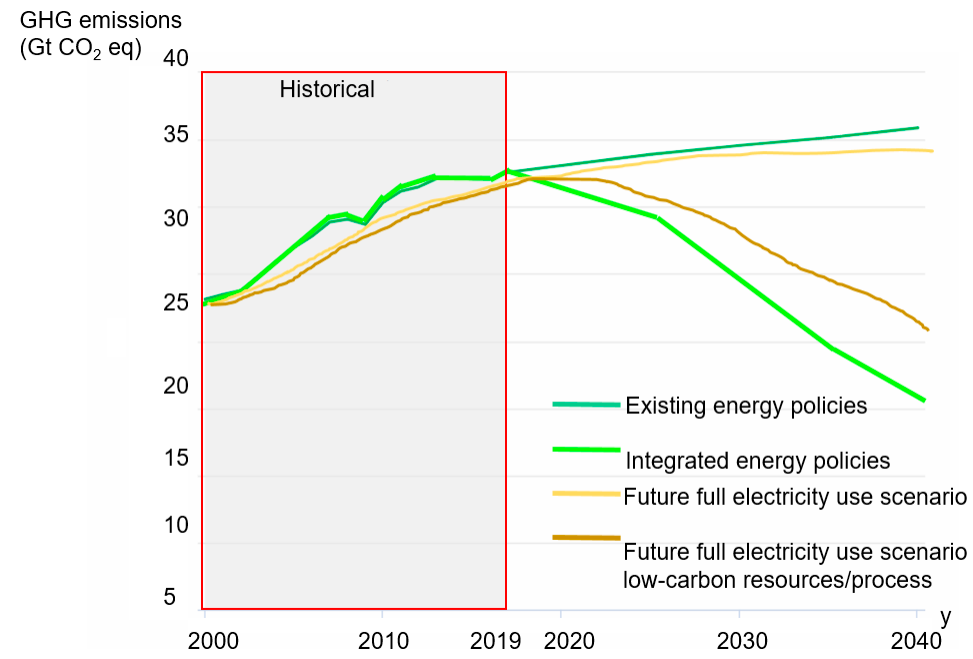
Figure 3. Predicted global GHG emissions with different energy policies, adapted from WEO [21].